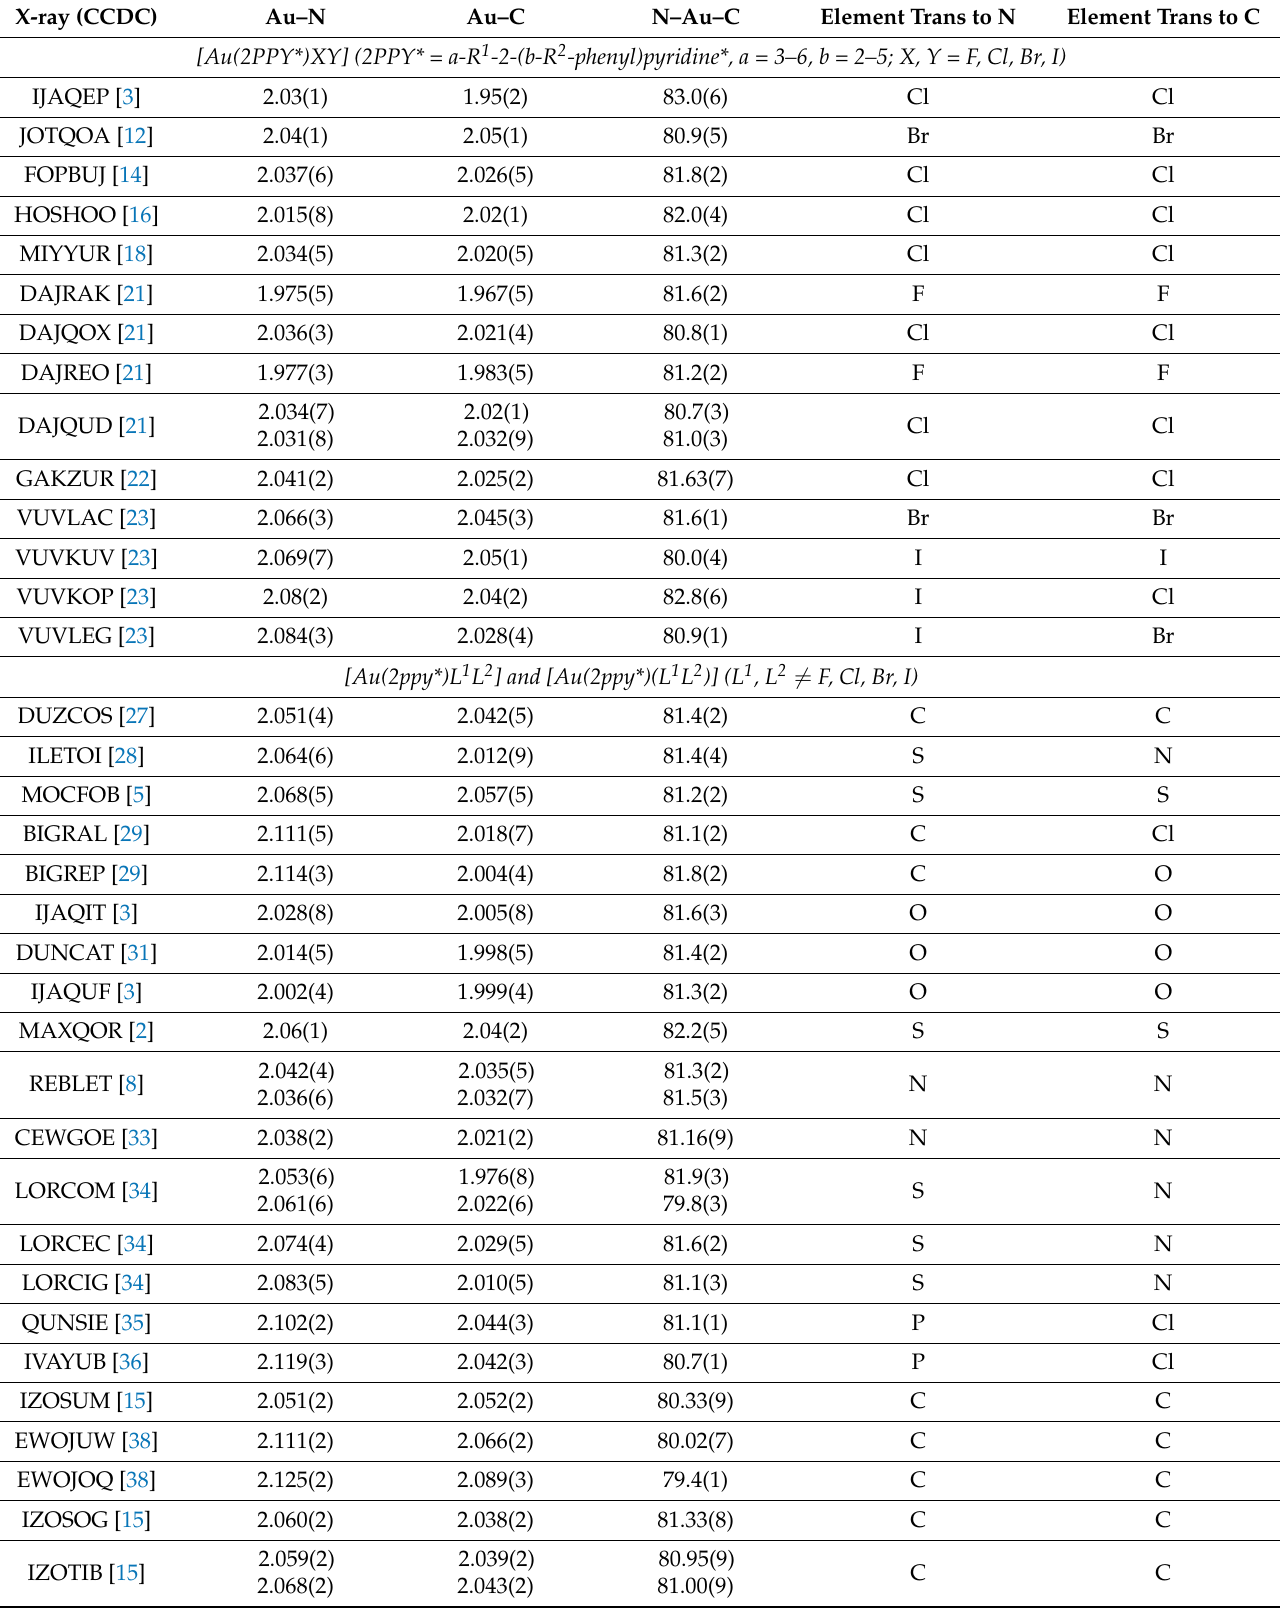
Table 7. Au–N and Au–C bond lengths [Å], as well as N–Au–C bond angles [ ◦ ] in Au(III)-2PPY* (including Au(III)-2ppy*), Au(III)-2ArPY*, and Au(III)-ArPY # *